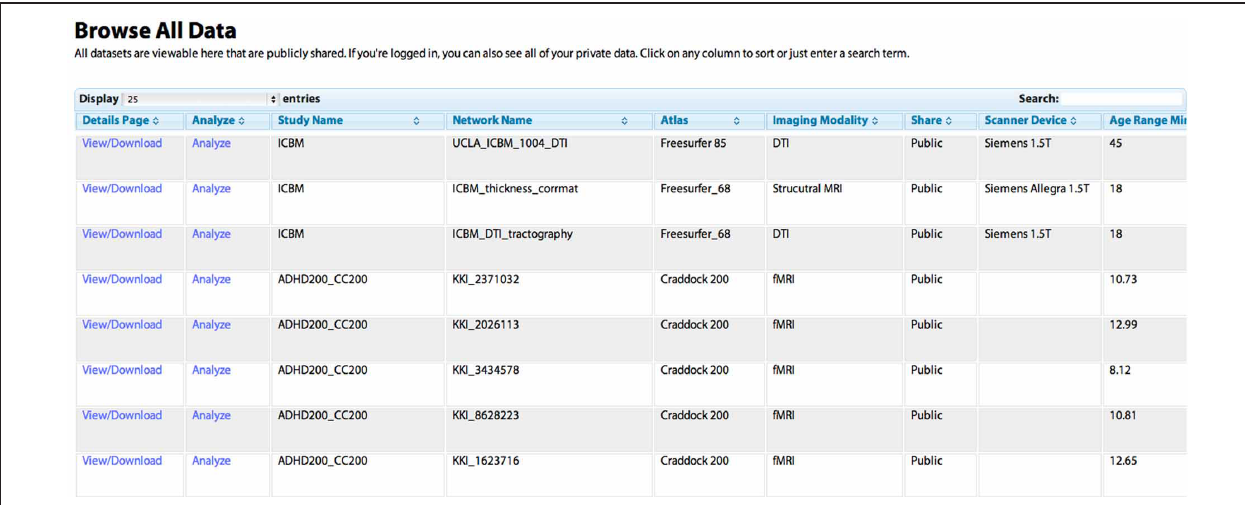
FIGURE 2 | The “Browse All Data” page. Studies are initially listed in the order in which they were shared by users. Any column can be sorted by clicking on the heading, allowing for example the grouping of all DTI studies, or the sorting of networks based on the age of the subject. The “Search” field can be used to dynamically constrain which records from the database